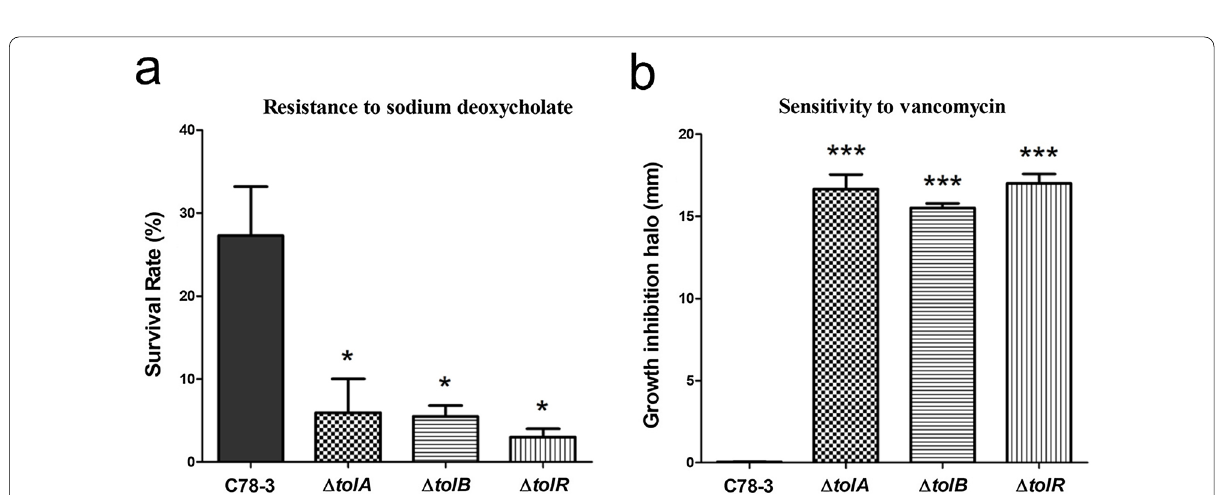
Fig. 3 Resistance to sodium deoxycholate and vancomycin of C78-3 and three mutants. a Survival of C78-3, Δ tolA , Δ tolB , and Δ tolR in 0.5% sodium deoxycholate. Bacterial strains were cultivated in LB to an OD 600 of 0.9. Then, the cells were resuspended in 0.5% sodium deoxycholate or PBS at 37 °C for 2 h. The survival rate was computed as (CFU in deoxycholic acid/CFU in PBS) 100%. b Resistance to vancomycin of C78-3, Δ tolA , Δ tolB , × and Δ tolR strains. The vancomycin disks contained 30 µg of the antibiotic. Each assay was completed in 3 independently conducted biology duplicates. * P < 0.05; ** P < 0.01; *** P <